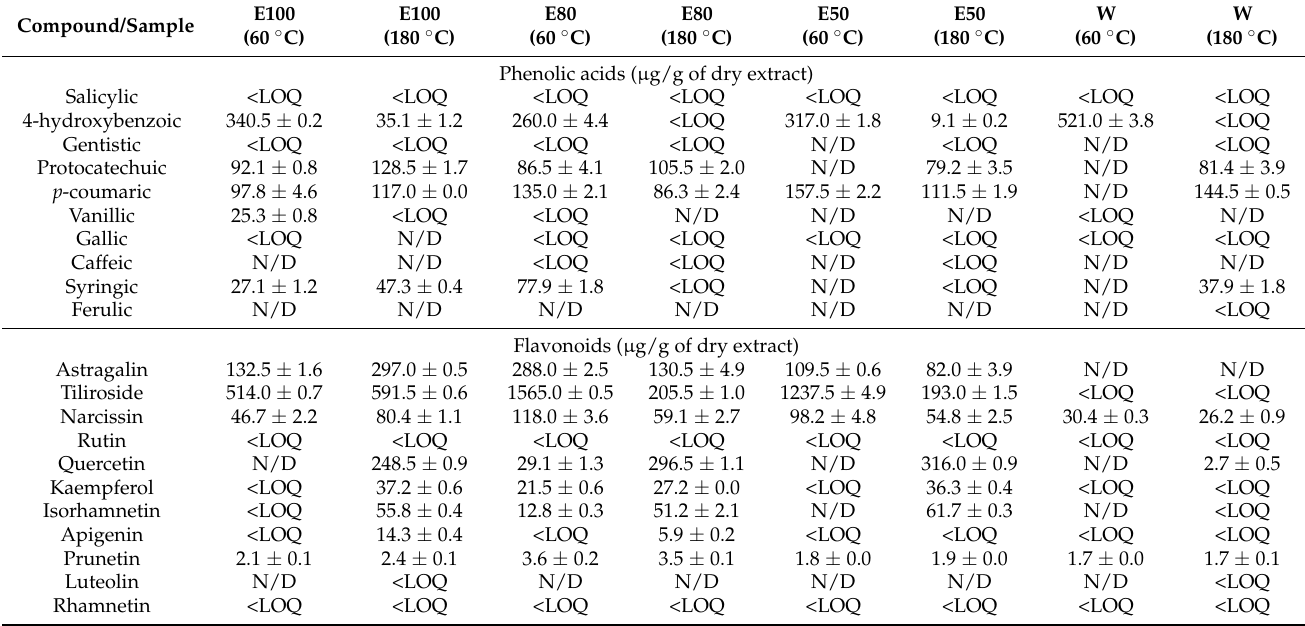
Table 4. Content of phenolic acids and flavonoids in some extracts obtained from the herb of Aerva lanata (L.) Juss. Mean values of three tests ( n = 3) with standard deviation ( ± SD). Abbreviations: <LOQ—limit of quantitation; N/D—not detected; for the other abbreviations, see Table 1.